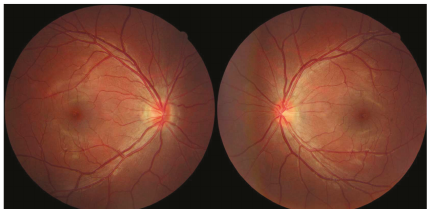
Figure 3: A 30-year-old male with bilateral decreased vision after taking ethambutol for treatment of tuberculosis for 6 months. The fundus shows optic disc hyperemia and he was identi fi ed as having mtDNA 11696